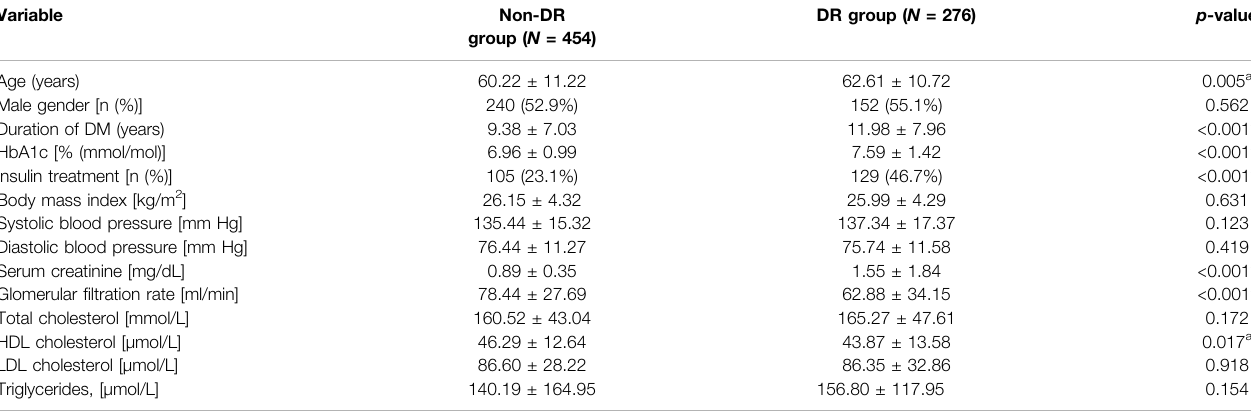
TABLE 1 | Clinical and laboratory characteristics of patients with diabetic retinopathy and no diabetic retinopathy. Variable